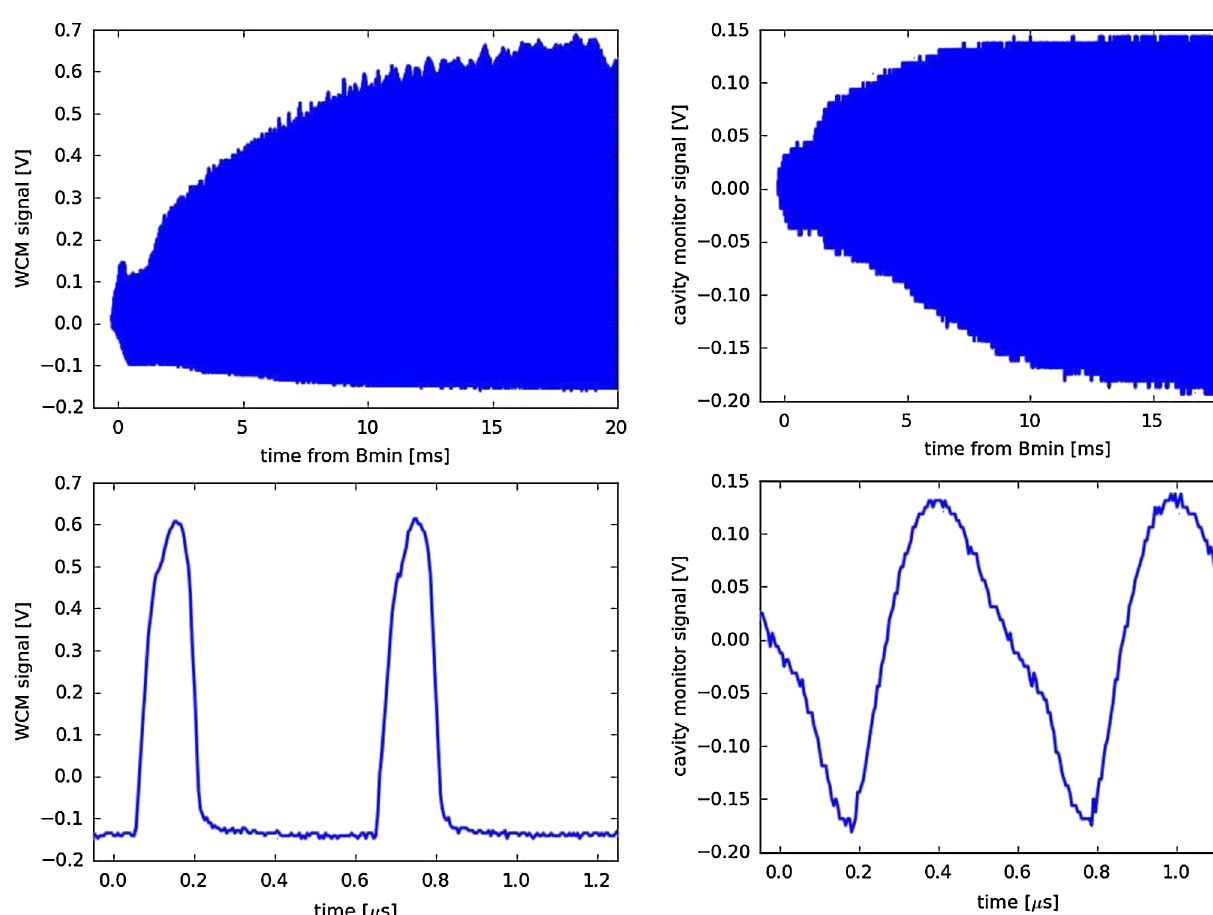
FIG. 5. The WCM signal (channel 2). The envelope of full waveform from the injection to the extraction (upper) and a magnified view near the extraction (lower).